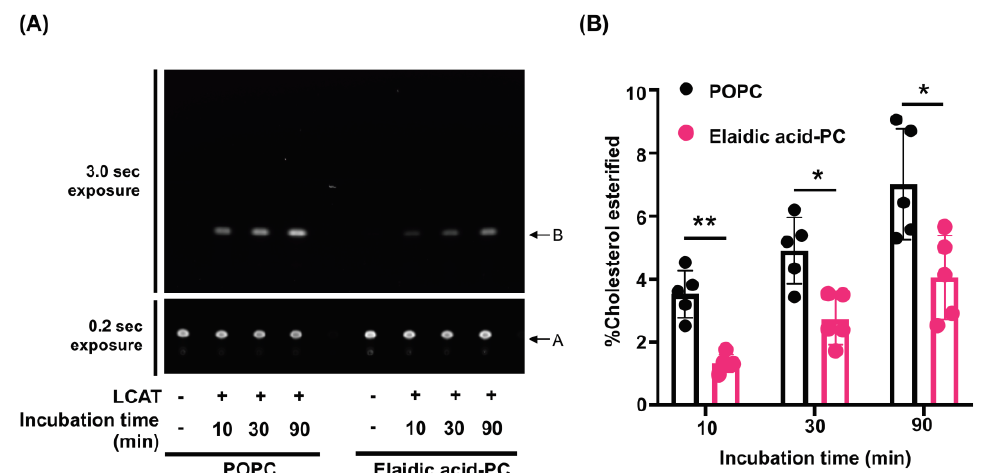
Figure 5. LCAT-dependent cholesterol esterification is suppressed in rHDL containing elaidic acid-PC. ( A ) rHDL containing both BODIPY-cholesterol and POPC or elaidic acid-PC were prepared and incubated with rhLCAT for 10–90min at 37 ◦ C. The extracted lipids were dissolved in 30 µ L of chloroform and applied to the TLC plate. The TLC plate was placed into a closed glass tank, saturated by a developing solvent (petroleum ether, diethyl ether, and acetic acid in mole portions of 230:60:3). After 25min, the plate was removed and the cholesterol spots (Position A) and esterified cholesterol spots (Position B) were detected using a ChemiDoc Touch MP. In order to visualize the spots clearly, cholesterol spots were exposed for 0.2 sec and esterified cholesterol spots were exposed for 3.0 sec. ( B ) The TLC plate was exposed for 0.2 sec and cholesterol spots and esterified cholesterol spots were quantified by densitometry analysis using ImageJ ® software. Cholesterol esterification rate was calculated as the percentage of cholesterol esterified during HDL incubation at 37 ◦ C for, 10–90 min. Values are expressed as the mean ± SD ( n = 5). * p < 0.05 ** p < 0.01. Data analyzed by unpaired Mann–Whitney